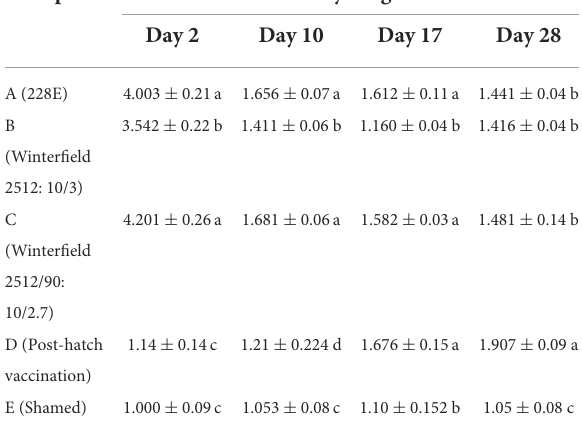
TABLE 8 Bursa: Body weight index of the White Leghorn chicks administered live IBD vaccines in ovo and post-hatch period at days 2, 10, 17, and